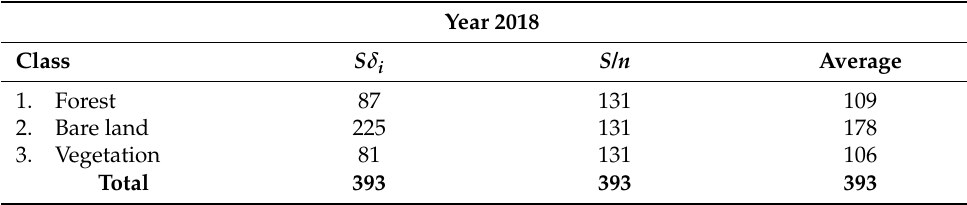
Table 11. Samples stratification for the classified data of the year 2018.